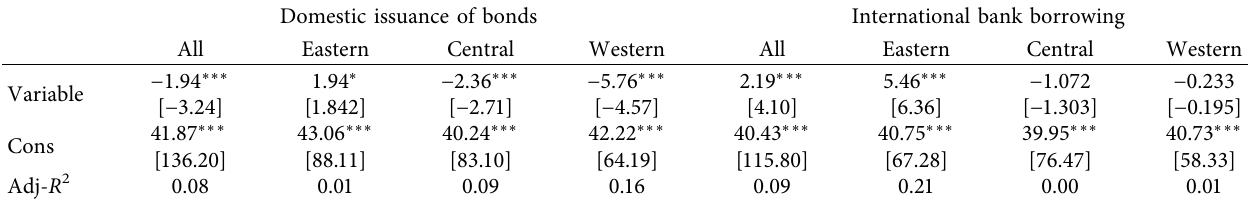
Table 8: Indirect fnancing efects of borrowing debt.